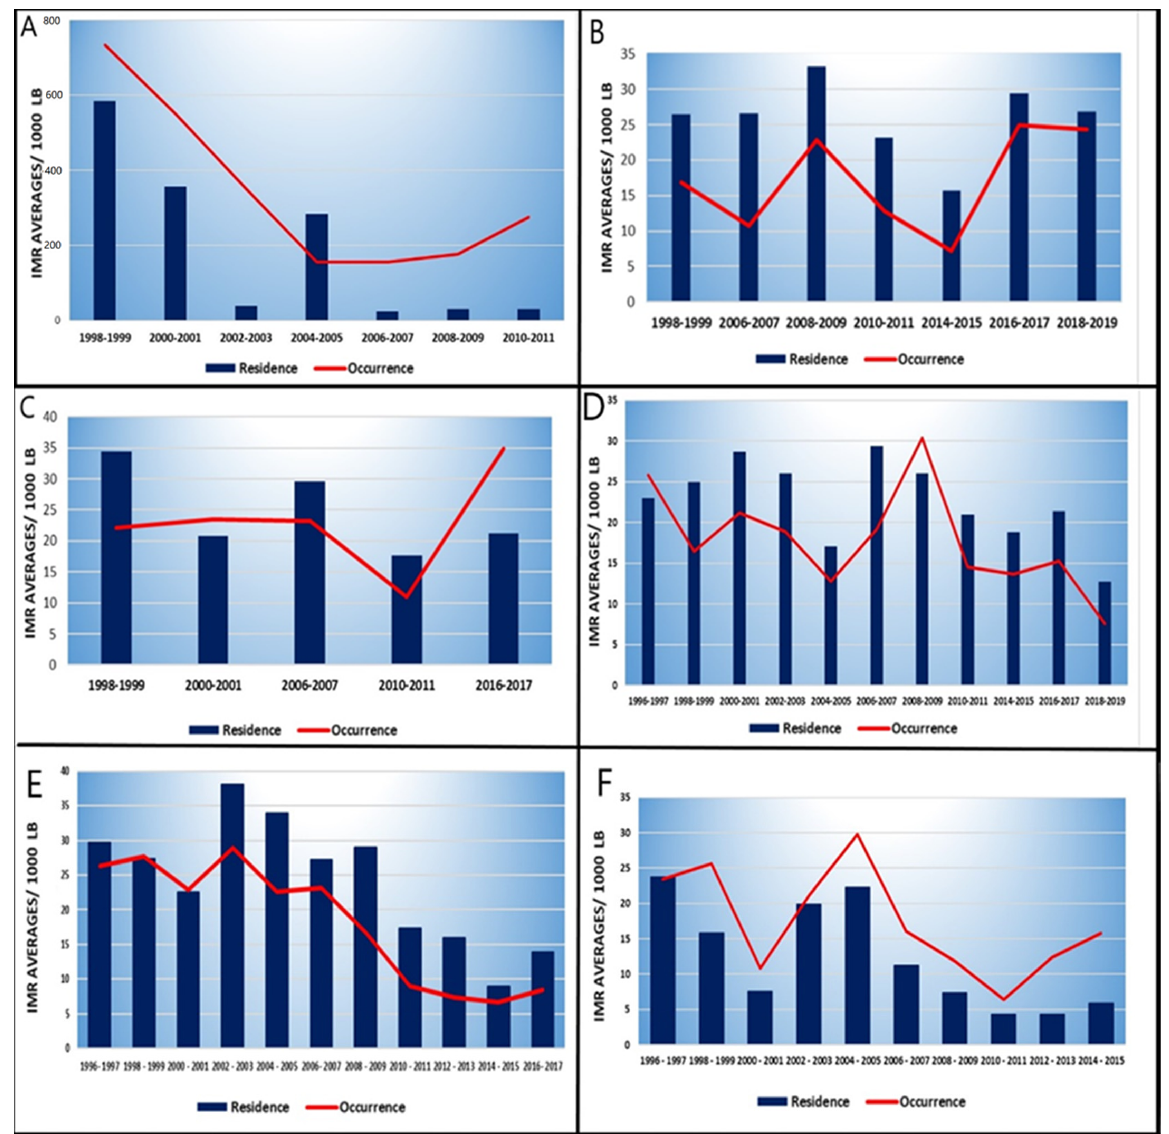
Figure 3. Change in infant mortality pattern through IMR averages per occurrence (red line) over the years in some Twin Cities: ( A ) Epitaciol â ndia–AC; ( B ) Pacaraima–RR; ( C ) Bonfim–RR; ( D ) New World–MS; ( E ) Bela Vista–MS and ( F ) Dionisio Cerqueira–SC. The HDI-M showed a negative correlation with the IMR (r= − 0.70) and a statistically significant one ( p -value < 0.001) (Figure 5). It is noteworthy that the higher the HDI-M, the lower the average of IMRs in the region, showing an inverse relationship between develop- ment and infant deaths. It is observed that cities in the North and Center-West regions have worse outcomes, such as the cities of Santa Rosa do Purus with Low Development with an HDI-M 0.517 and an average IMR of 38.91 deaths/1000 LB. In sequence, the Twin City Paranhos—MS with 31.26 deaths/1000 LB and the HDI-M 0.588, with low